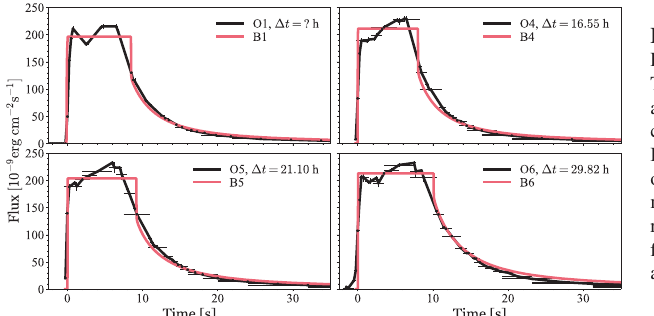
Figure 1. SAX J1808.4 − 3658 PRE bursts of Epoch Oct 2002 . The observed bursts O1, O4, O5, and O6 (black lines), and the corresponding modeled bursts B1, B4, B5, and B6 (red lines) based on the restored Johnston et al . [6] model using Hu et al. 22 Mg( α, p) reaction rate [8] with mass fractions X H / X He = 0 . 413 / 0 . 567 and time dependent accretion